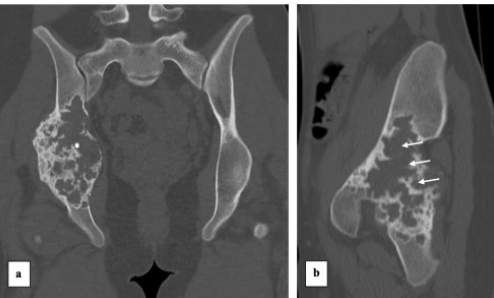
Figure 3. CT scan, coronal ( a ) and sagittal ( b ) views. CT scan reveals an intraosseous mass (star) centered on zone 2 Enneking, but with extension including zones 1 and 3. Marked cortical osteolysis, especially in the posterior region towards the sacroiliac joint (arrows).